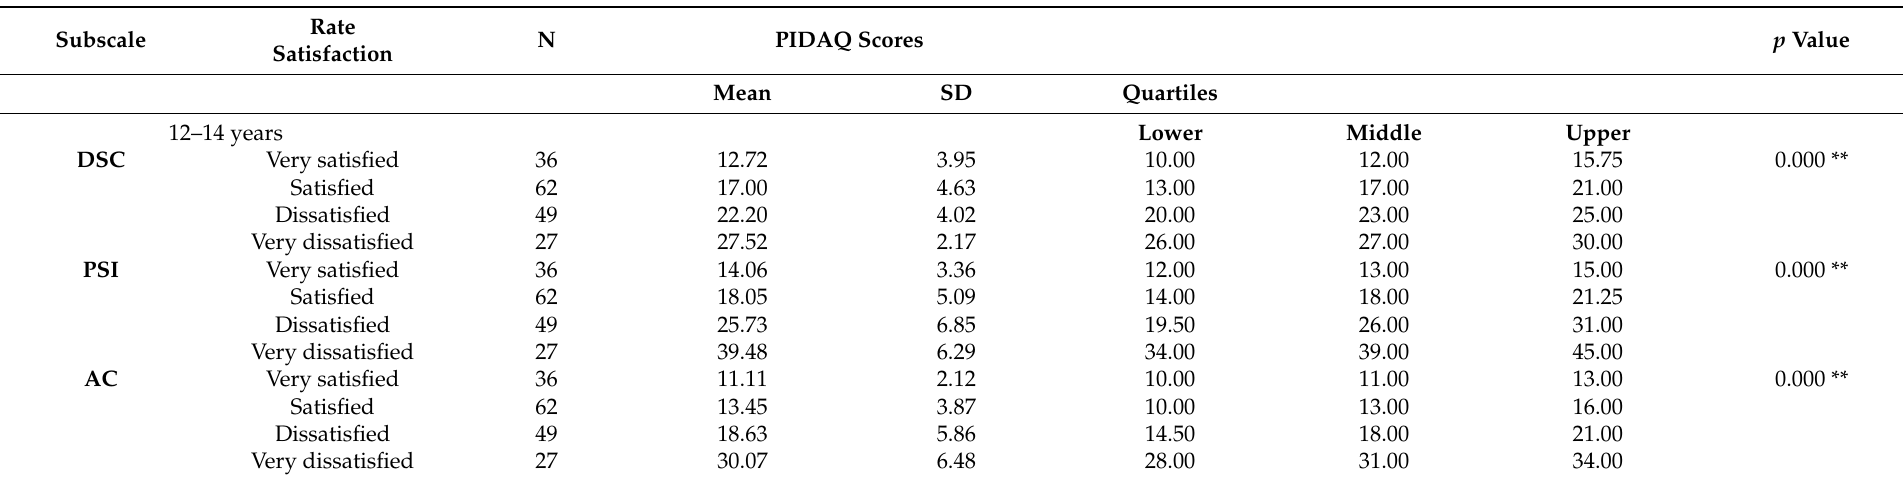
Table 7. Convergent validity: association between the PIDAQ(A) and perceived satisfaction with dental